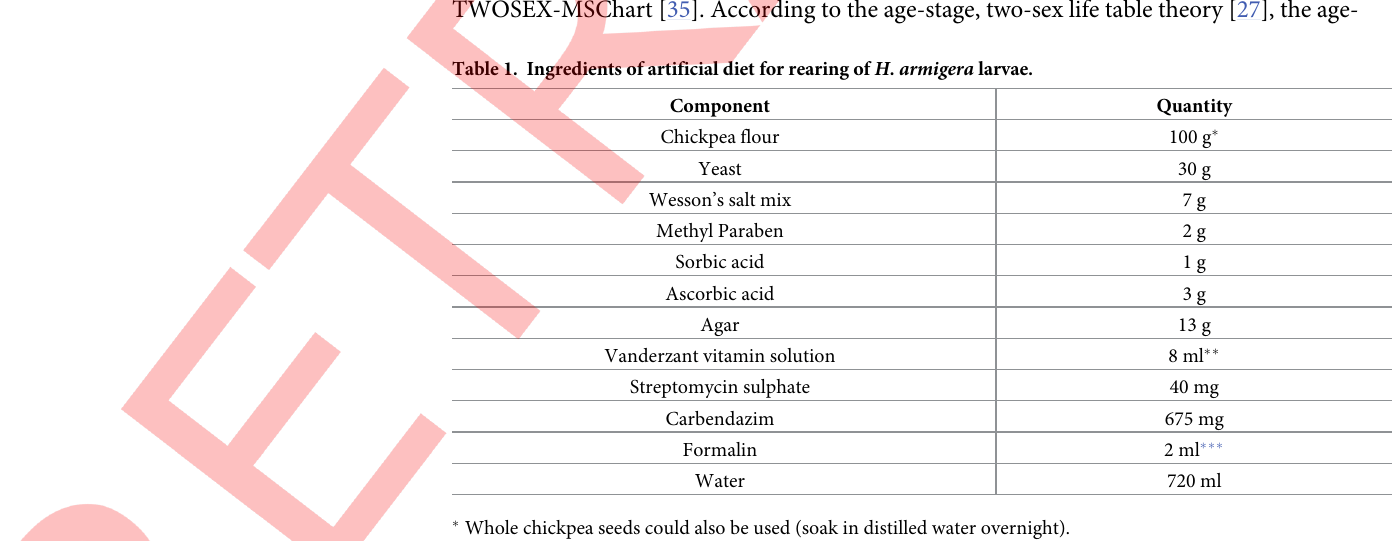
Table 1. Ingredients of artificial diet for rearing of H . armigera